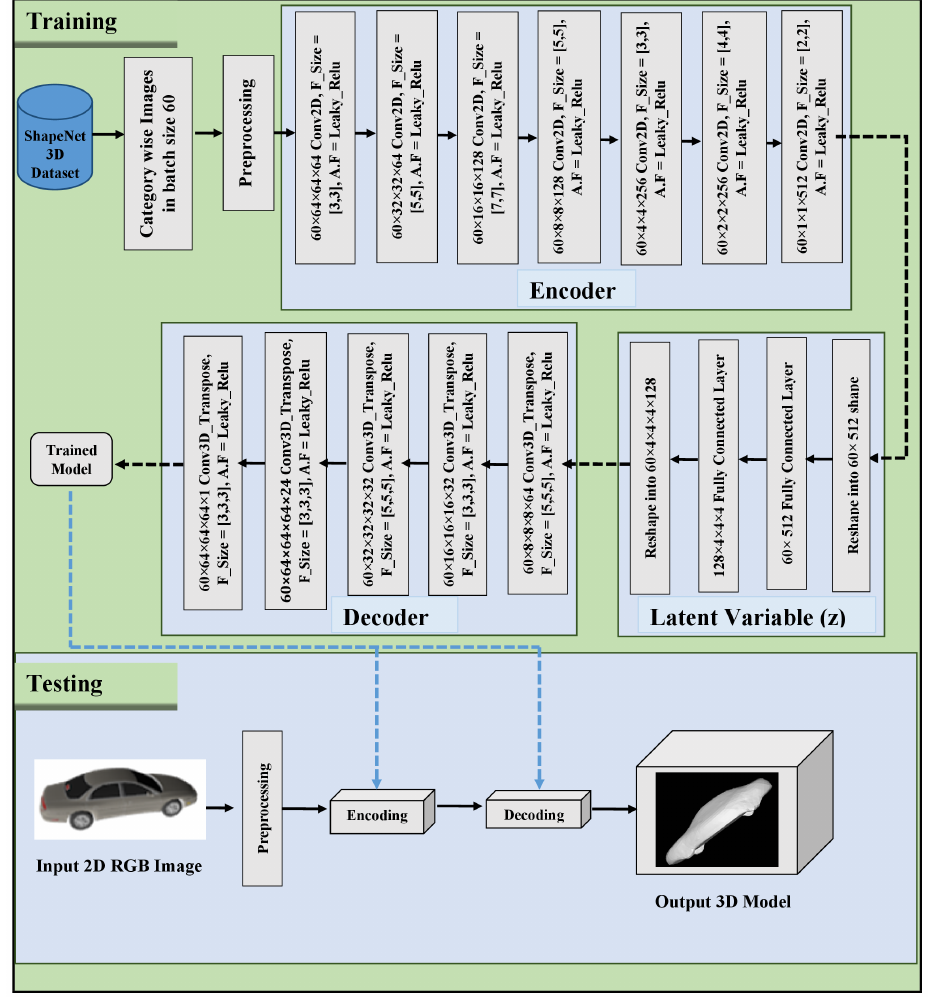
Figure 2. Detailed Architecture of the Proposed Autoencoder